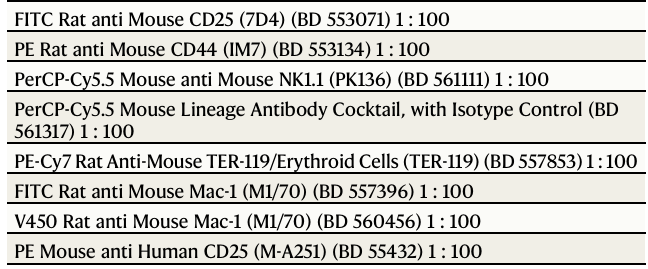
PE Rat anti Mouse CD44 (IM7) (BD 553134) 1 : 100 PerCP-Cy5.5 Mouse anti Mouse NK1.1 (PK136) (BD 561111) 1 : 100 PerCP-Cy5.5 Mouse Lineage Antibody Cocktail, with Isotype Control (BD 561317) 1 :